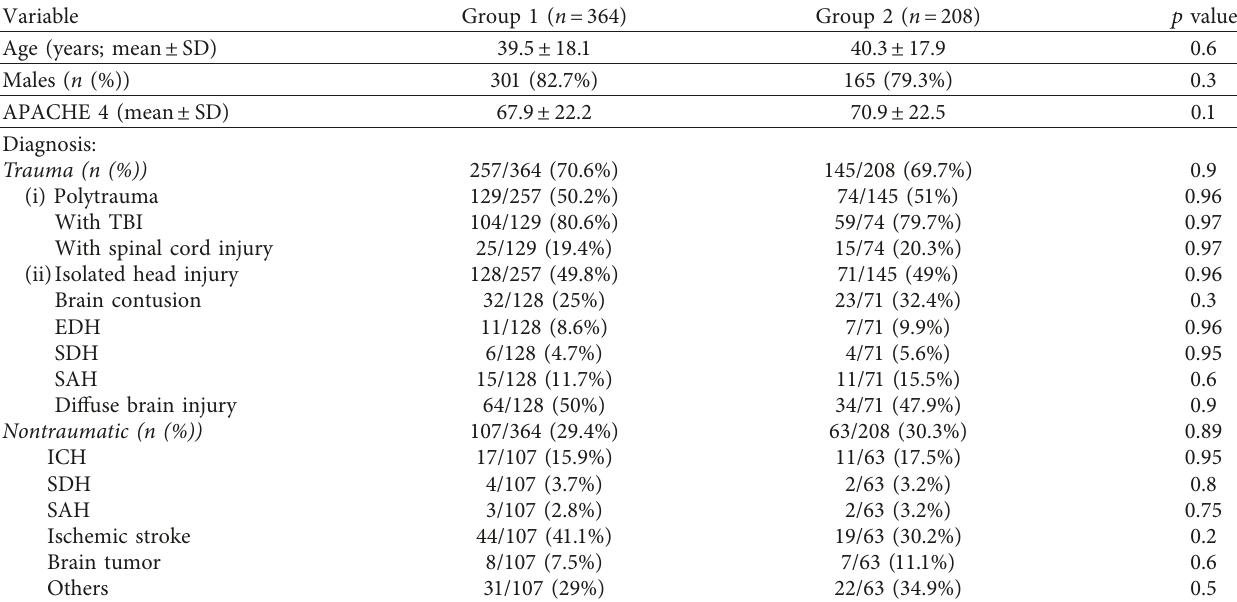
Table 1: Study demographics.